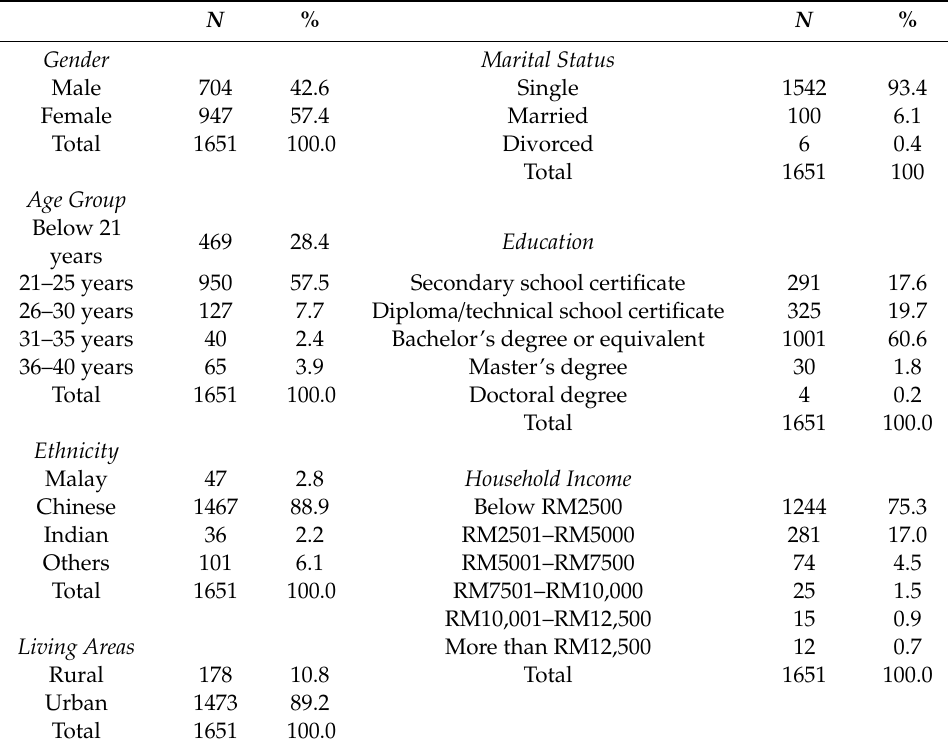
Table 1. Demographic